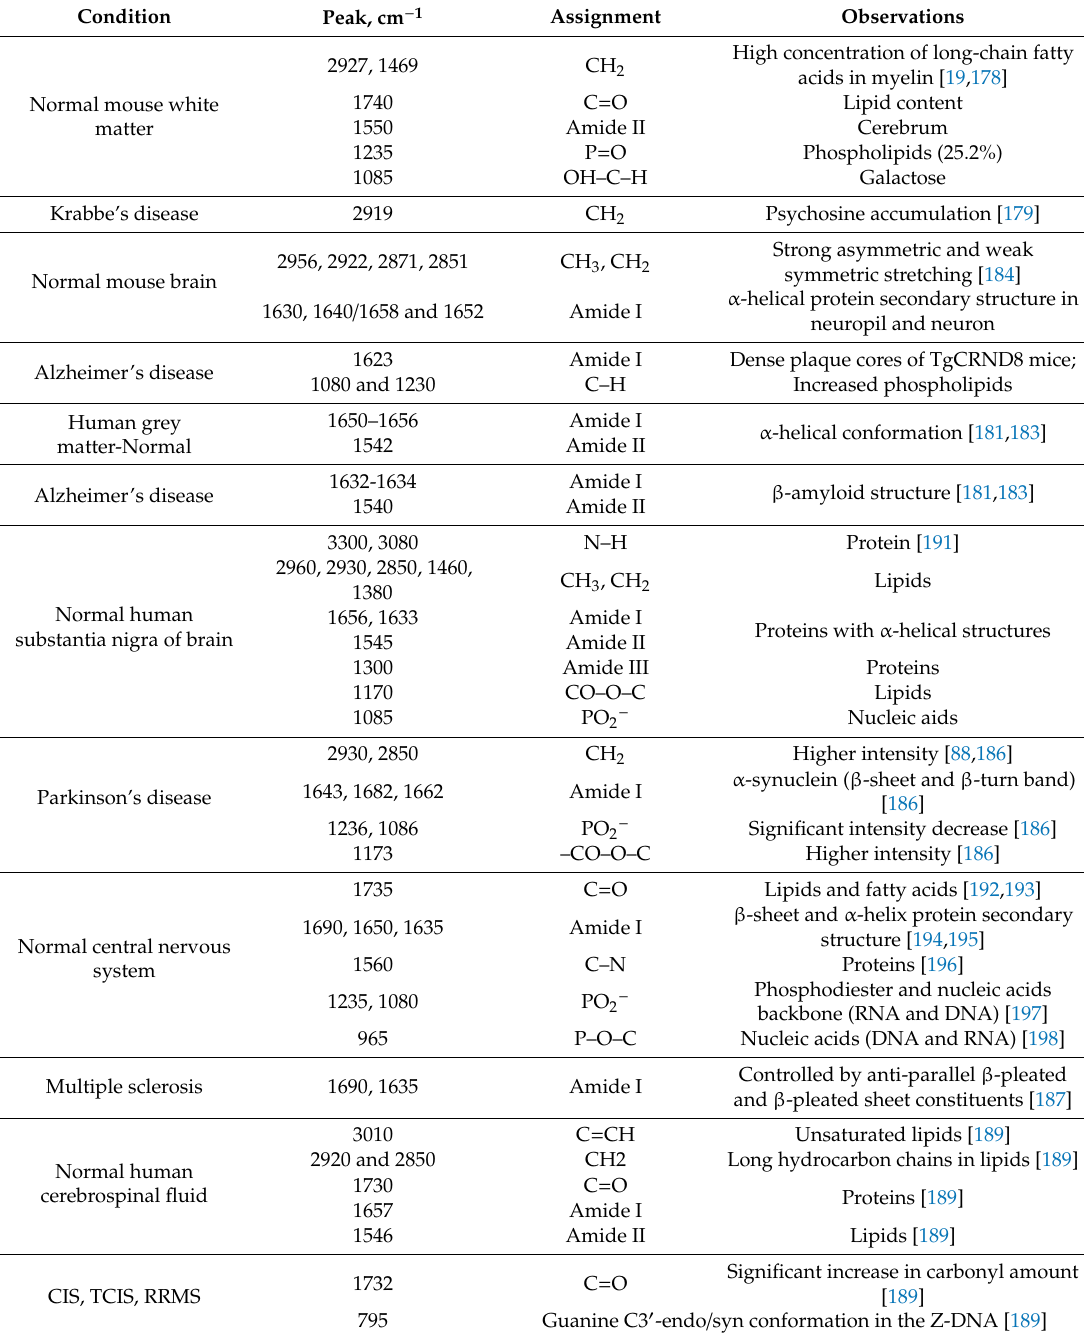
Table 8. Distribution of typical absorption bands acknowledged in brain tissues.